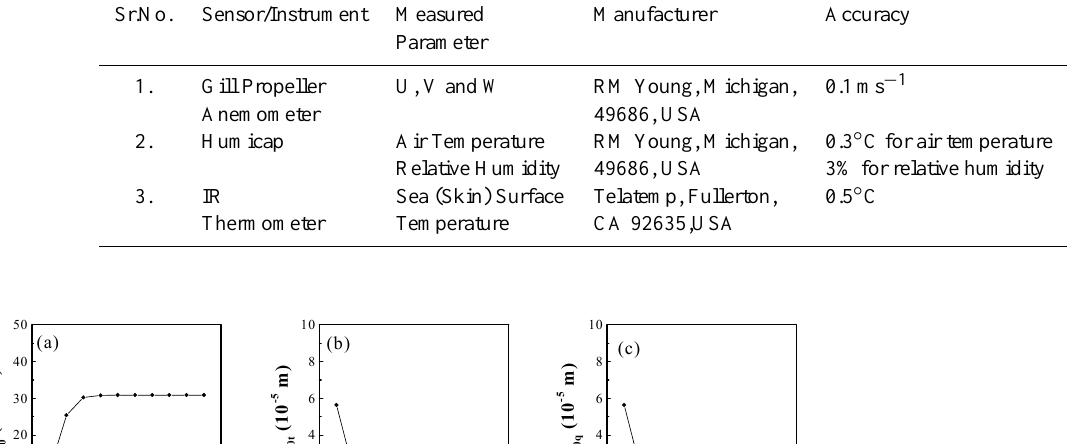
Fig. 2. Iterative estimates of (a) veloc- ity roughness length ( z 0 , × 10 − 5 m), (b) roughness length for temperature ( z 0 t , × 10 − 5 m), (c) roughness length for humidity ( z 0 q , × 10 − 5 m), (d) sta- bility function 9 m (e) stability function 9 h , (f) stability function 9 q , (g) scal- ing parameter for wind u ∗ (ms − 1 ), (h) scaling parameter for temperature θ ∗ (K) and (i) scaling parameter for hu- midity q ∗ (kg.kg − 1 ) with the number of